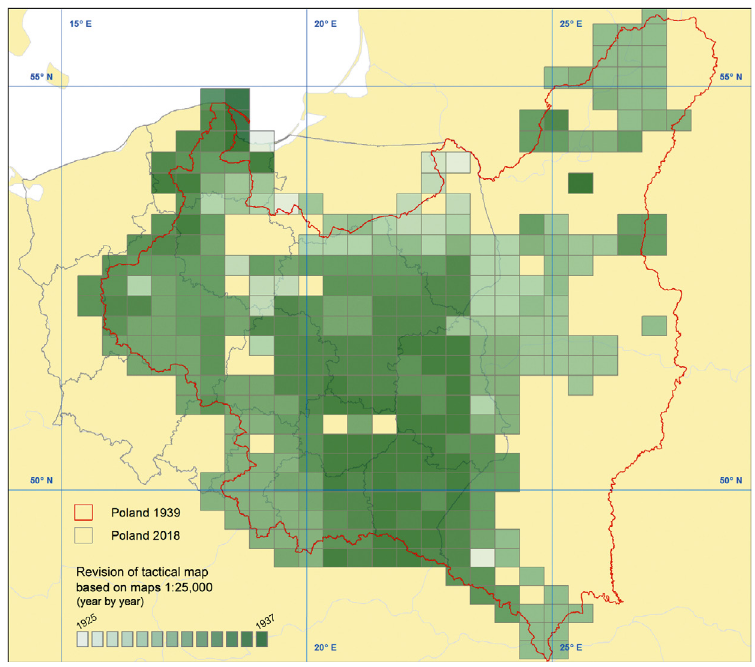
Fig. 1. The revision of MGI’s 1:100,000 tactical map based on maps at the scale 1:25,000 or